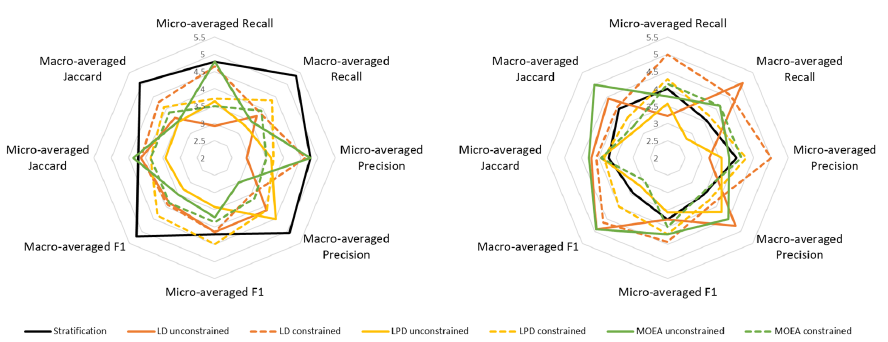
Figure 3. Average ranks of the different methods when classification is performed using Binary Relevance. Left figure shows the ranks regarding classification metrics. Right figure shows the ranks regarding the variance over folds.